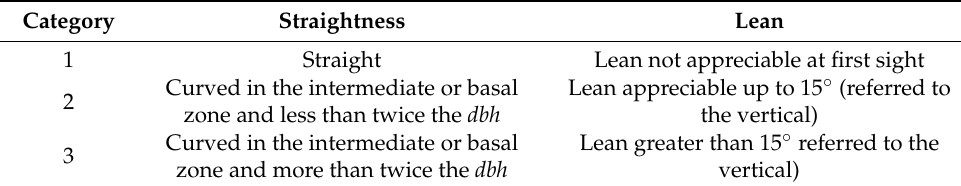
Table 1. Scale of values used as a reference to measure stem shape variables in the field.